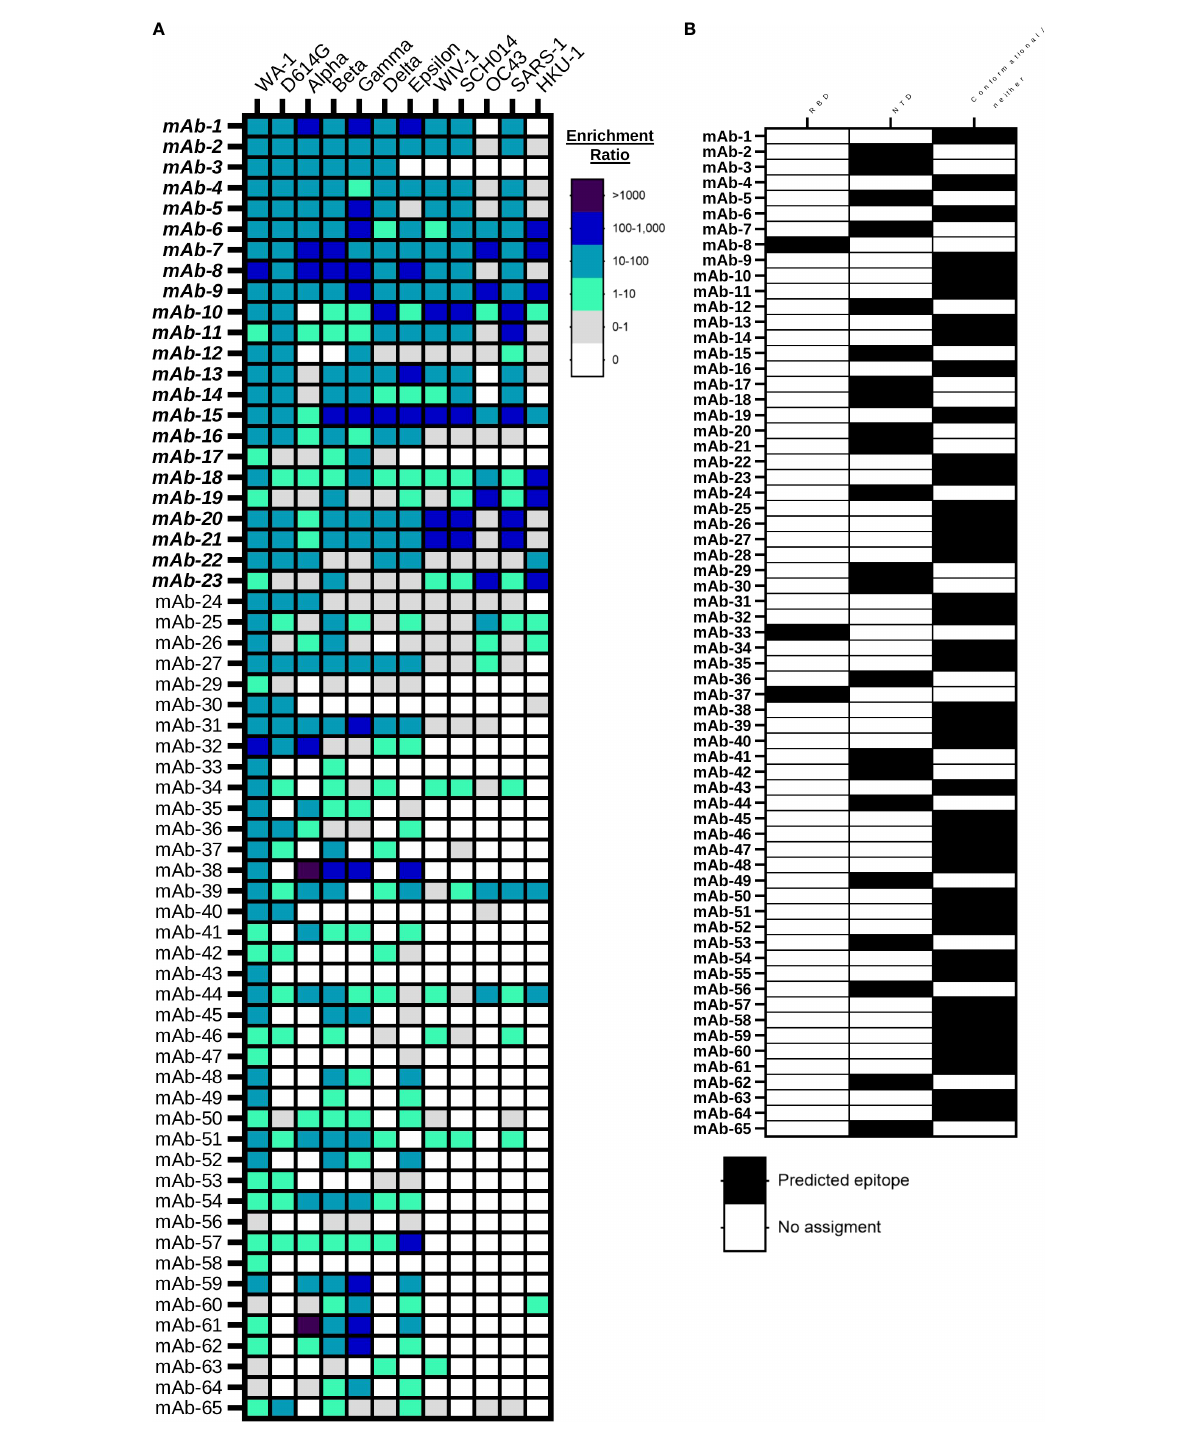
FIGURE 3 Large-scale betacoronavirus recognition breadth and epitope mapping analyses for anti-SARS-CoV-2 mAbs. (A) Bioinformatic analysis of yeast display library enrichment ratios determined by NGS after 2 rounds of enrichment against broad coronavirus S2P probes. Antibodies were screened against eight SARS-CoV-2 variants (SARS-CoV-2 WA-1, D614G, Alpha, Beta, Gamma, Delta, and Epsilon) and six broader betacoronaviruses (WIV-1, SCH014, OC43, SARS-1, MERS and HKU-1). Enrichment against MERS Spike protein was not observed, and is omitted here. (B) Bioinformatic analysis of monoclonal antibody recognition of SARS-CoV-2 variants RDB and NTD subdomain probes based on enrichment ratios in NGS sort